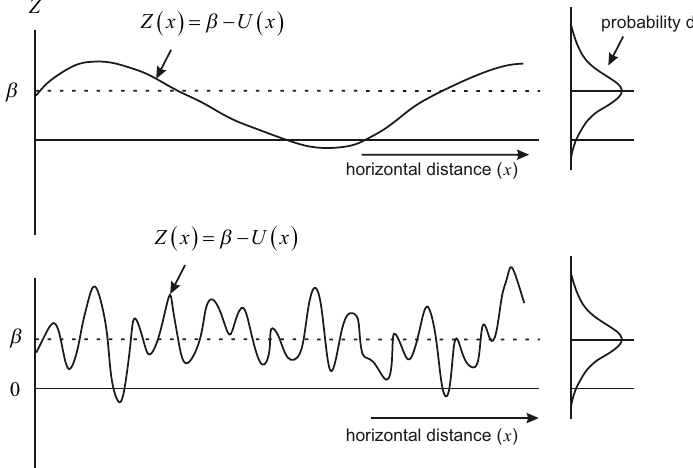
Figure 3. Spatial variability of the limit state function Z for a strongly autocorrelated Z function ( top ) and a weakly autocorrelated Z function ( bottom